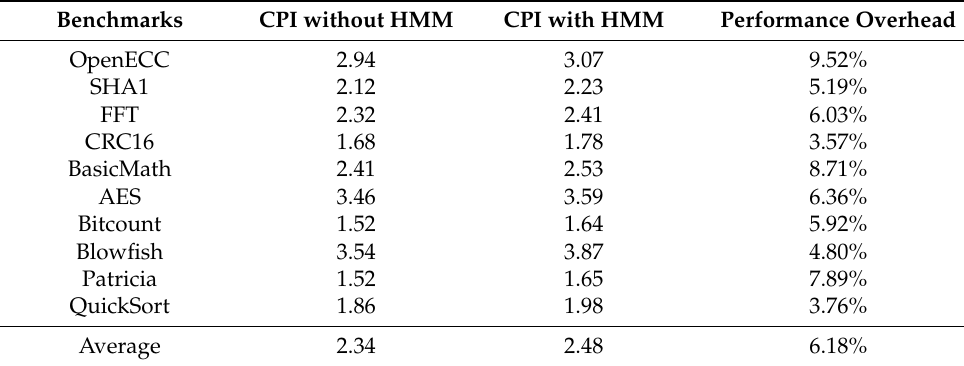
Table 8. The performance overhead of the processor configured with